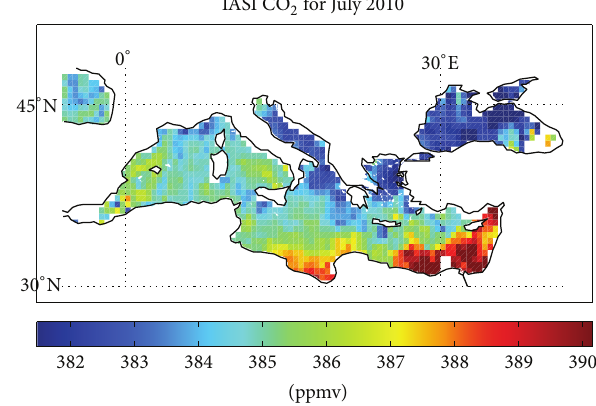
Figure 6: Retrieved atmospheric ozone content for the month of July 2010. Data have been smoothed and rendered on a grid of 0.5 ∘ × 0.5 ∘ (lat. × lon.).